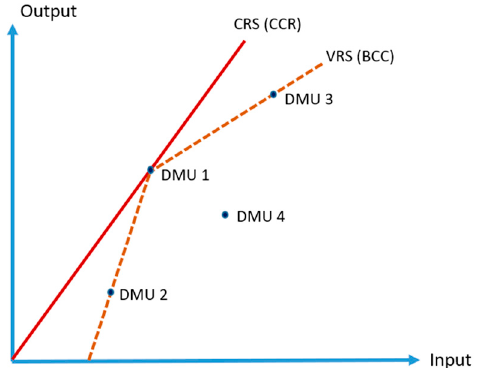
Figure 3. DEA CRS and VRS efficiency frontiers and four DMUs.